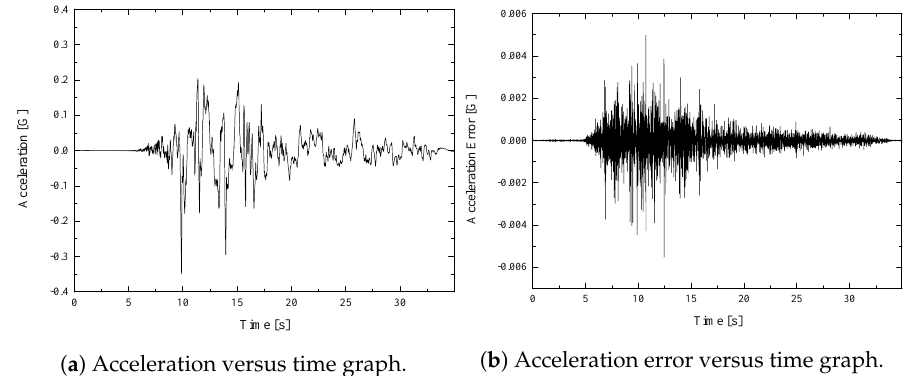
Figure 11. Seismic shake table experimental results for the 1999 Kocaeli earthquake reference seismic waves.